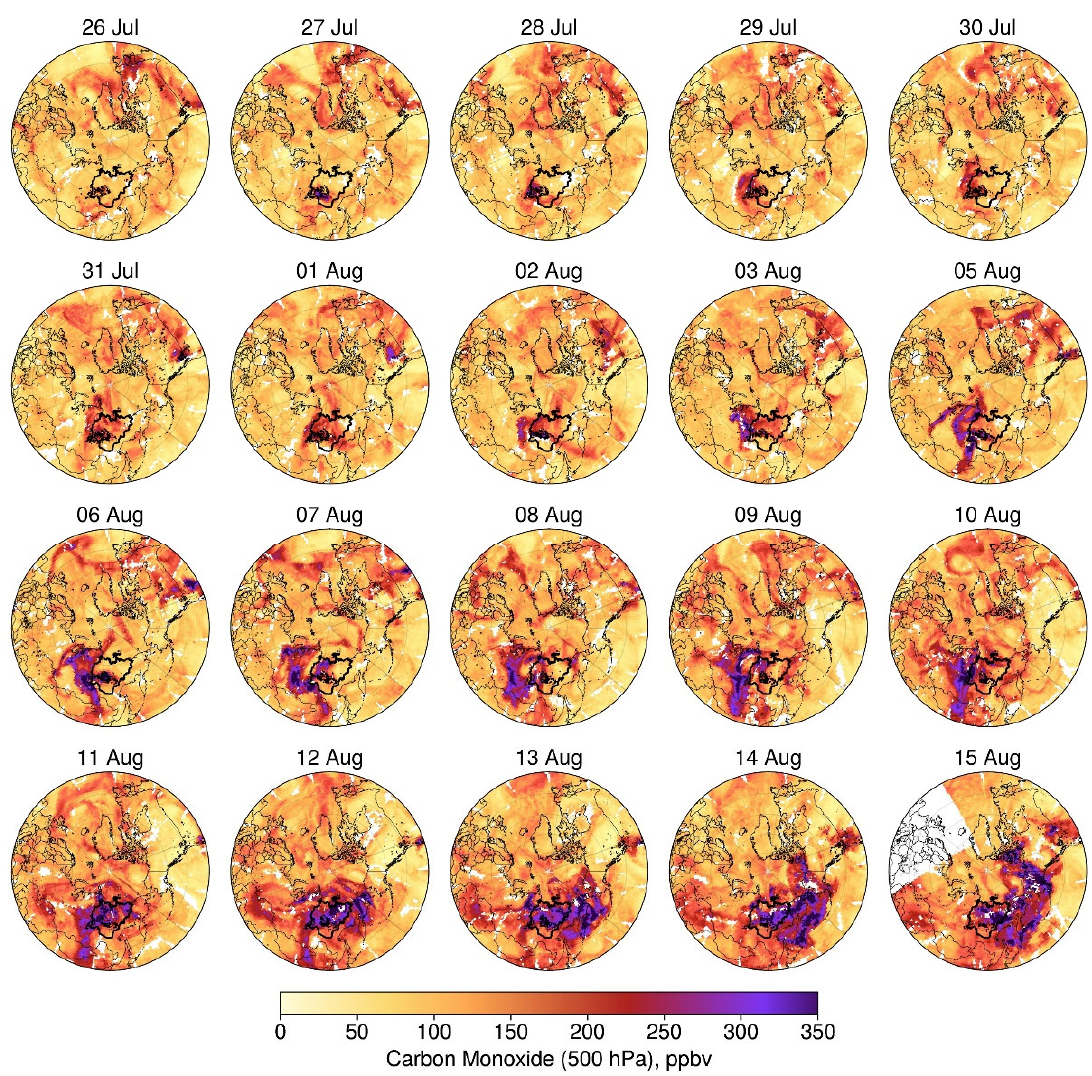
Figure 11. Spatial distribution of AIRS carbon monoxide concentration at 500 hPa during the second period of wildfire intensification in the study region (26 July–15 August). The bold solid line indicates Yakutia administrative boundary, black dots—MODIS hotspots.